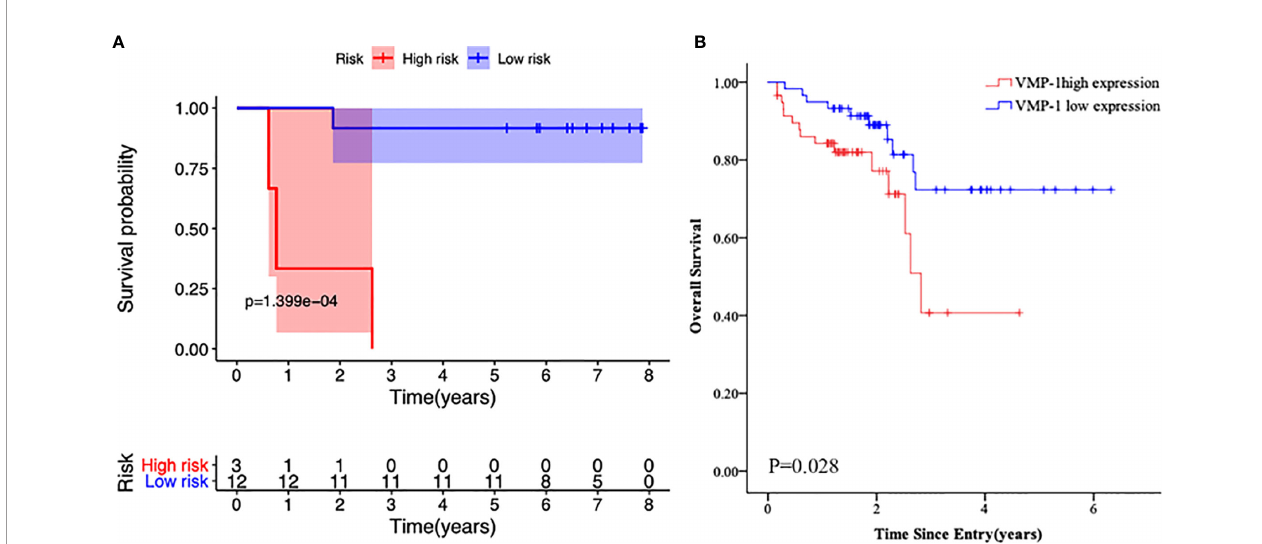
FIGURE 5 | Kaplan-Meier survival curves of the primary cohort according to VMP1 gene expression. (A) Survival probability in bi CEBPA AML patients with VMP1 high vs. low VMP1 expression. (B) Survival probability in normal karyotype AML patients with VMP1 high vs. low VMP1